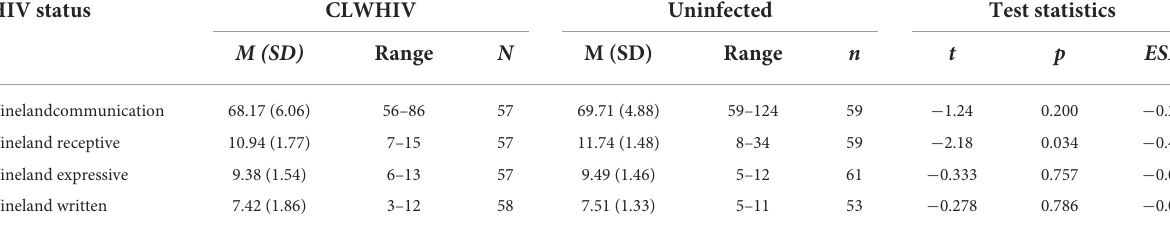
TABLE 3 Between group differences on the Vineland Adaptive Behavior Scale: Communication domain a .